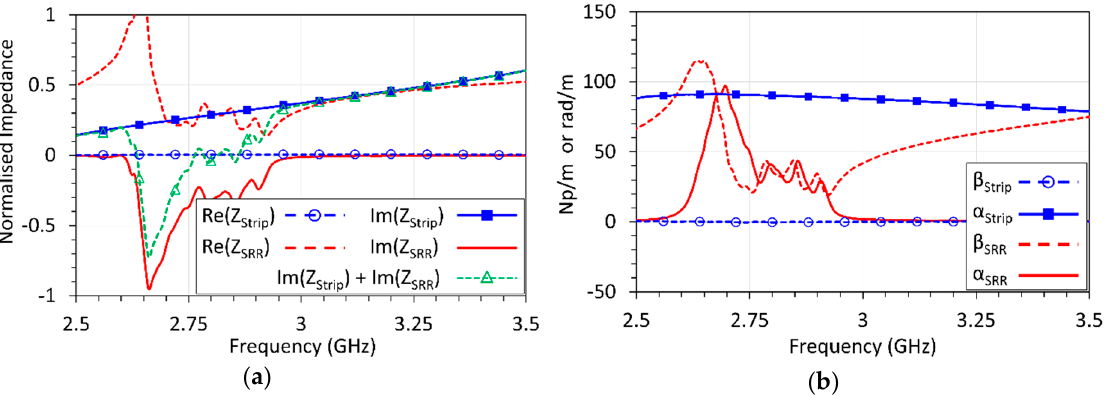
Figure 9. Extracted TE 10 mode ( a ) normalized wave-impedance, ( b ) attenuation and phase constants for strip and SRR loaded waveguide. (In color.).